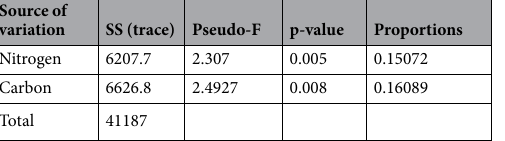
Table 1. Distance based linear model statistical test (DistLM) for correlation between fungal community composition and nitrogen and carbon content in bulk, rhizosphere and pneumatophore soil